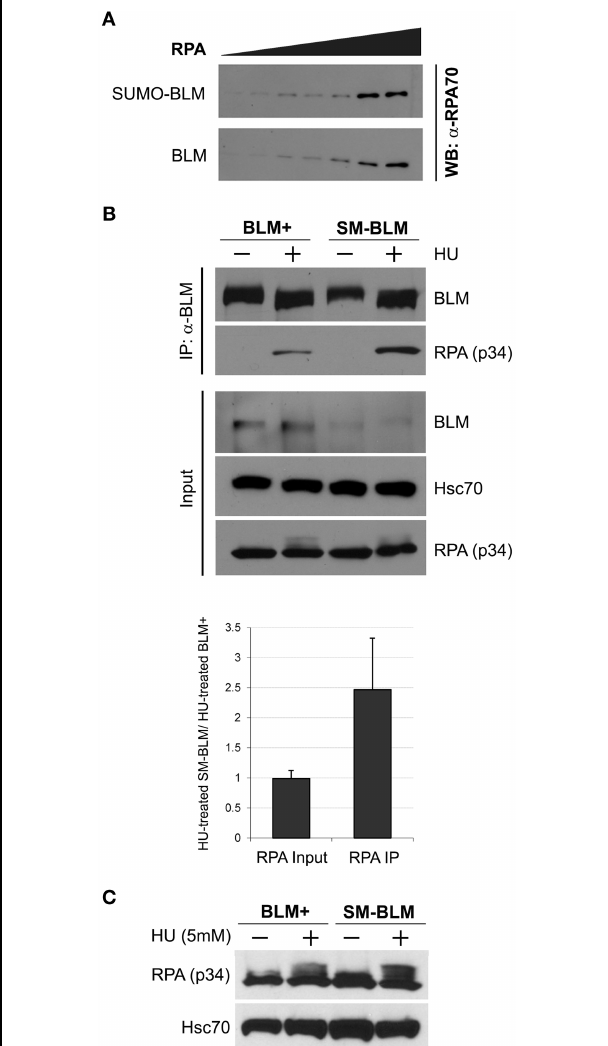
FIGURE 5 | Excess BLM-RPA complex forms in SM-BLM cells. (A) SUMOylation of BLM did not affect BLM-RPA binding in vitro . SUMOylated (SUMO-BLM) or unSUMOylated (BLM) BLM were bound to Ni-NTA beads and incubated with increasing amounts of purified human RPA protein for 30min at room temperature. The beads were washed three times. Bound RPA protein was analyzed by immunoblot with anti-RPA/p70 antibody. A bead-only experiment showed that no excess RPA bound to beads in the absence of BLM. (B) BLM binds more RPA in SM-BLM cells than BLM + cells. Cells were untreated or treated with 5mM HU for 6h. Immunoprecipitation of RPA was carried out using antibodies to the GFP tag on GFP-BLM. Input consisted of 2% of the initial cell extracts. Hsc70 was used as a loading control. A minimum of two independent experiments were carried out for each of two BLM + and two SM-BLM clones. The graph depicts the ratio of input and immunoprecipitated RPA in HU-treated SM-BLM cells over HU-treated BLM + cells. (C) HU does not induce significantly different levels of RPA and phosphorylated RPA in